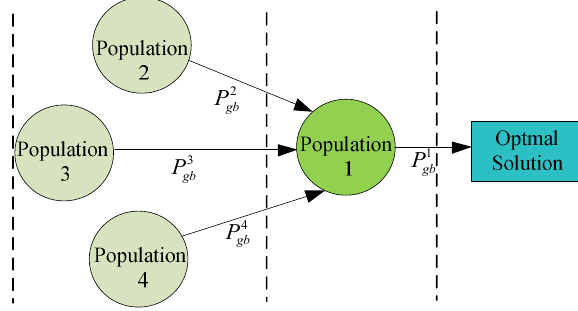
Figure 6. Multi-population cooperation searching strategy.